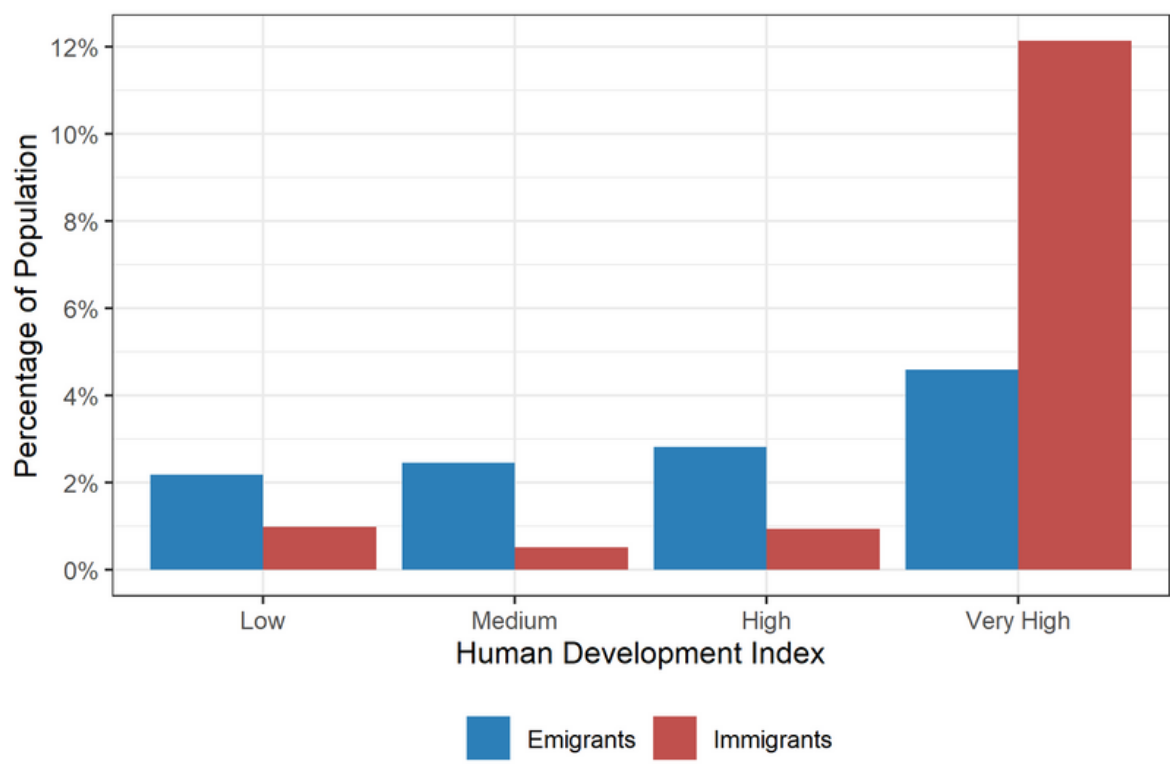
Figure 2. Immigrants and emigrants by Human Development Index country category, 2020. From UN DESA (2021b) and UNDP